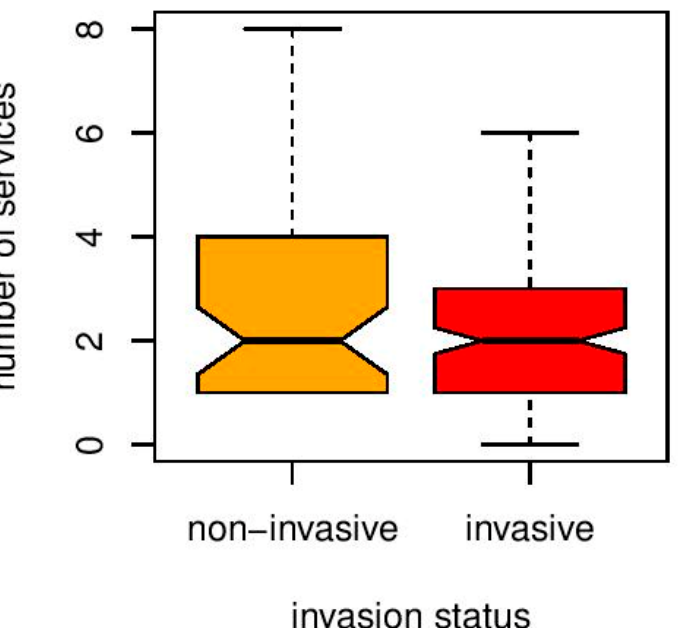
Figure 1. Relationships between the number of known services provided by alien species and their invasion status.